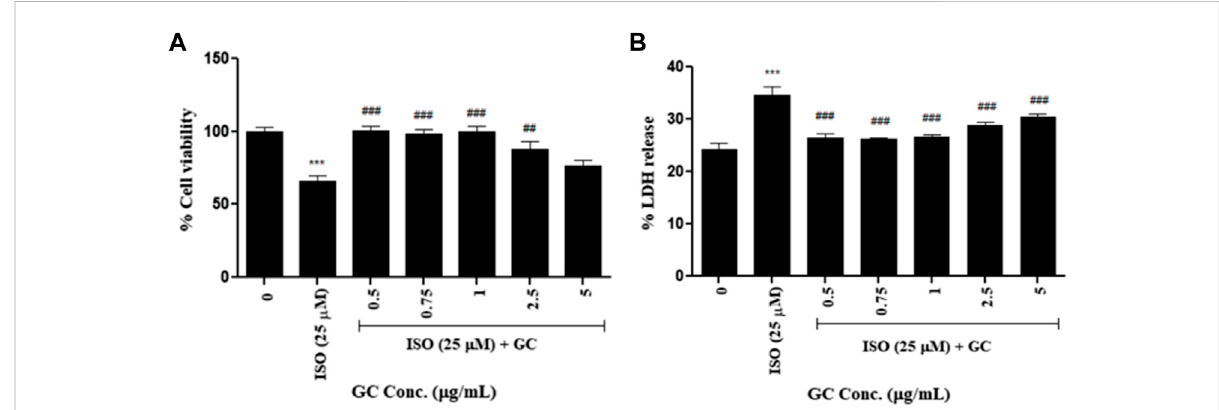
FIGURE 2 Cell viability assay- (A) MTT and (B) LDH release assay in ISO (25 µM) induced cardiotoxicity model in H9c2 cell line with GC pretreatment at different concentrations (µg/ml). Data expressed as mean ± SD for groups of three observations. Statistically signi fi cant *** p < 0.001 compared to control group and ### p < 0.001 compared to ISO group as calculated by one-way ANOVA followed by Dunnet ’ s multiple comparison tests).